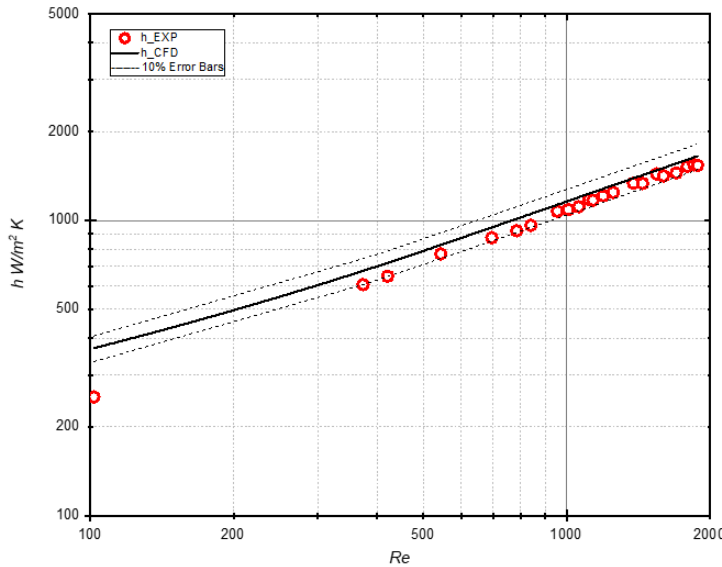
Figure 14. Heat transfer coefficient versus Reynolds number for pipe flow.